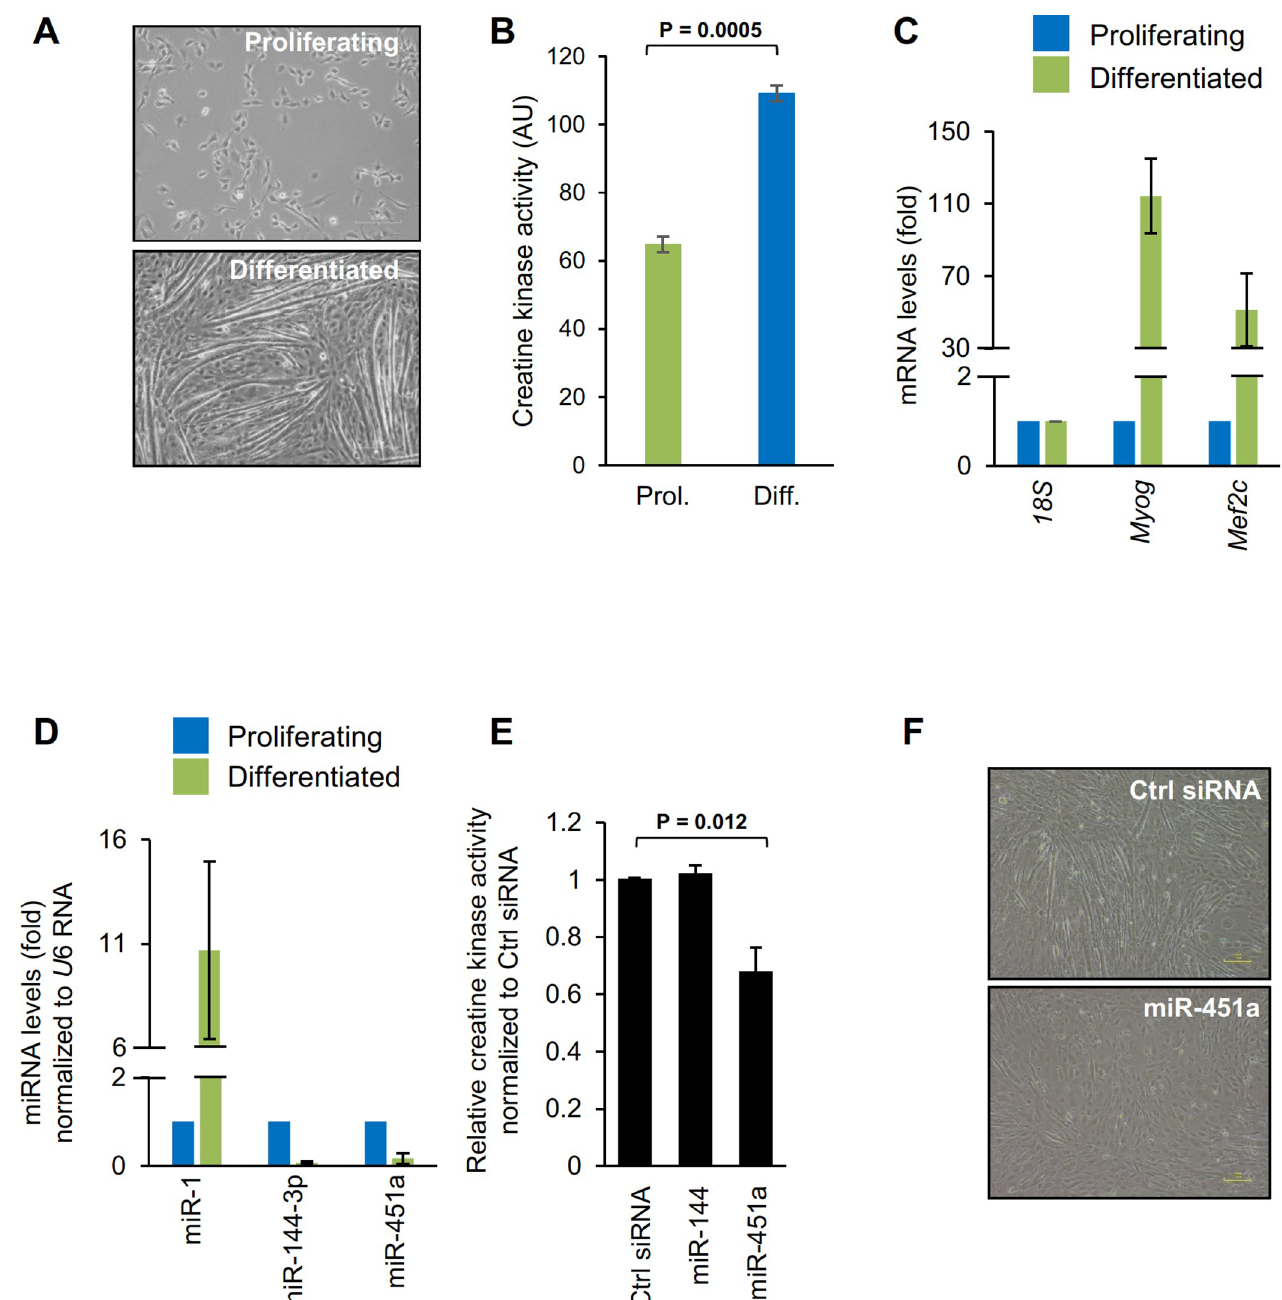
Fig 1. Inhibition of myoblast differentiation by miR-451a. (A) Phase-contrast microscopy of C2C12 cells that were cultured in either proliferating medium or cultured for 6 days in differentiating medium. (B) Creatine kinase levels in the proliferating C2C12 cells and differentiated myotubes. (C) Changes in mRNA levels upon C2C12 myoblast differentiation on day 6 as quantified by RT-qPCR using 18S rRNA as normalization control. (D) RT-qPCR analysis of miR-1, miR-144-3p, and miR-451a in proliferating and differentiated C2C12 myoblasts. (E) Analysis of creatine kinase activity in differentiated C2C12 myoblasts transfected with the indicated miRNAs. (F) Phase-contrast fields of C2C12 cells transfected with Ctrl siRNA or miR-451a mimic followed by culture for 5 days in differentiation medium. Data in panel A-D represent the means ± SEM from 3 independent experiments. Significance (P) is indicated. https://doi.org/10.1371/journal.pone.0214301.g001 in differentiating C2C12 cells compared to proliferating myoblasts (S2 Table) (a partial list of mRNAs differentially expressed during C2C12 differentiation was reported earlier [7]). From